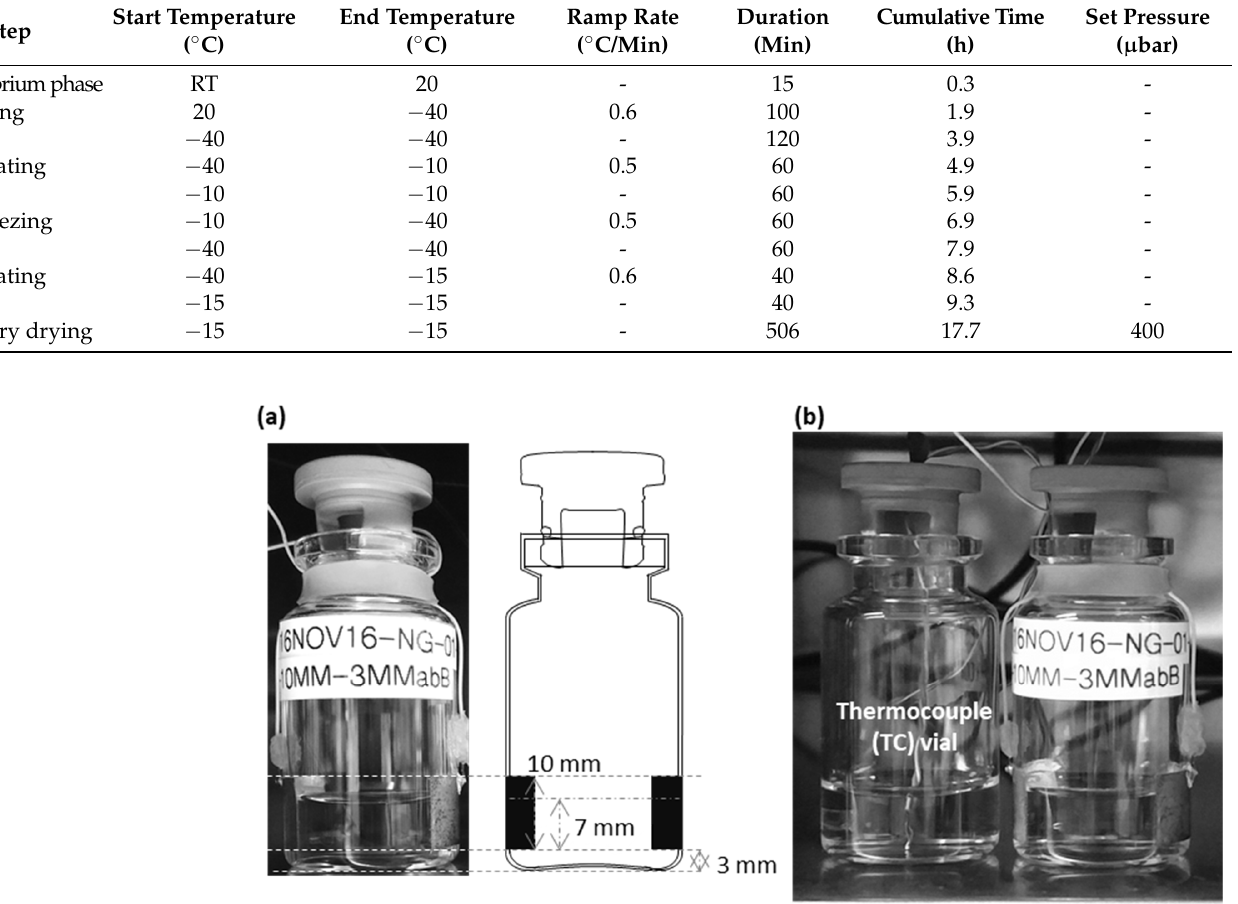
Table 1. Freeze-drying cycle for the TVIS vial containing 3 g of double distilled water.